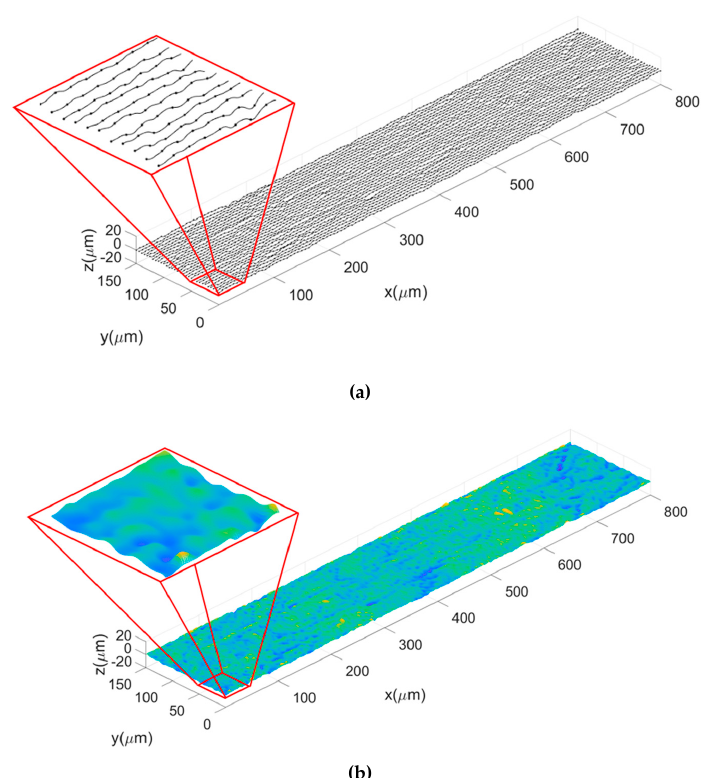
Figure 4. Measured profiles and the simulated surface of a medium rough specimen (Specimen No. 2): ( a ) measured profile data and ( b ) a generated NURBS surface.